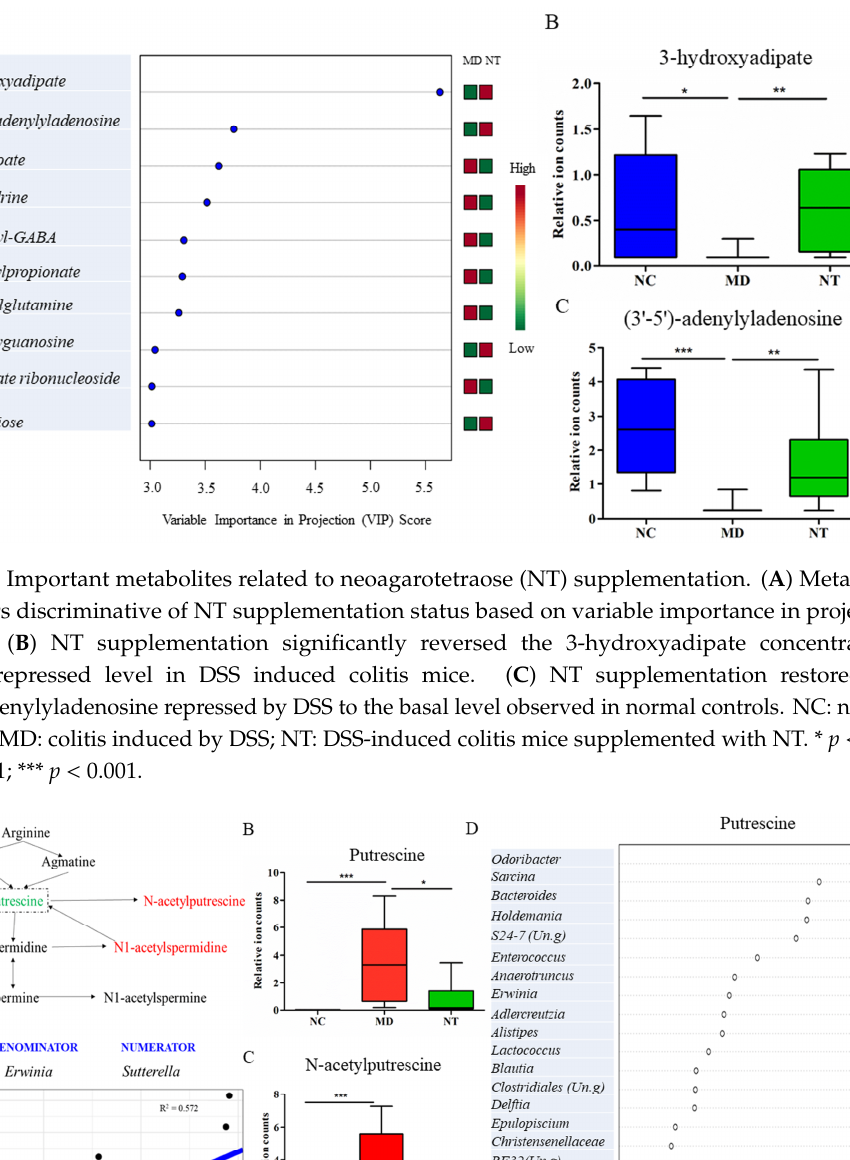
Sutterella (numerator) displayed a good correlation with putrescine levels (R 2 = 0.572), as shown in Figure 8E. Microorganisms 2020 , 8 , x FOR PEER REVIEW